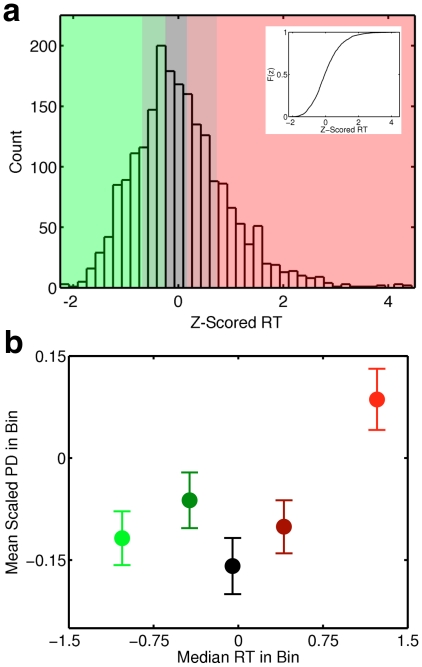
Extremely slow response times to correct WM probes are associated with high baseline PD.(a) Reaction times (RTs) to all 2103 correct working memory responses (Experiments Two and Three) were within-subject z-transformed and then pooled. These RTs were divided into five equal mass bins whose boundaries were determined using the cumulative RT distribution (inset) and are denoted by the colored areas in the main panel. (b) Binned, mean scaled PD for the 1.5 second window before correct WM probes, plotted against median bin RT. ANOVA including Experiment (Two/Three) as a between-participants variable indicated a significant effect of pupil size on subsequent RT (F (4, 108) = 7.02, p<.001, η2 = .19). No additional main effects or interactions were significant (all p-values >.05). Post-hoc comparisons (Bonferroni corrected) among the ANOVA results indicated that the slowest bin differed significantly from all other bins except the fourth bin (all corrected p-values <.05). No other inter-bin differences were significant (all p-values >.05).